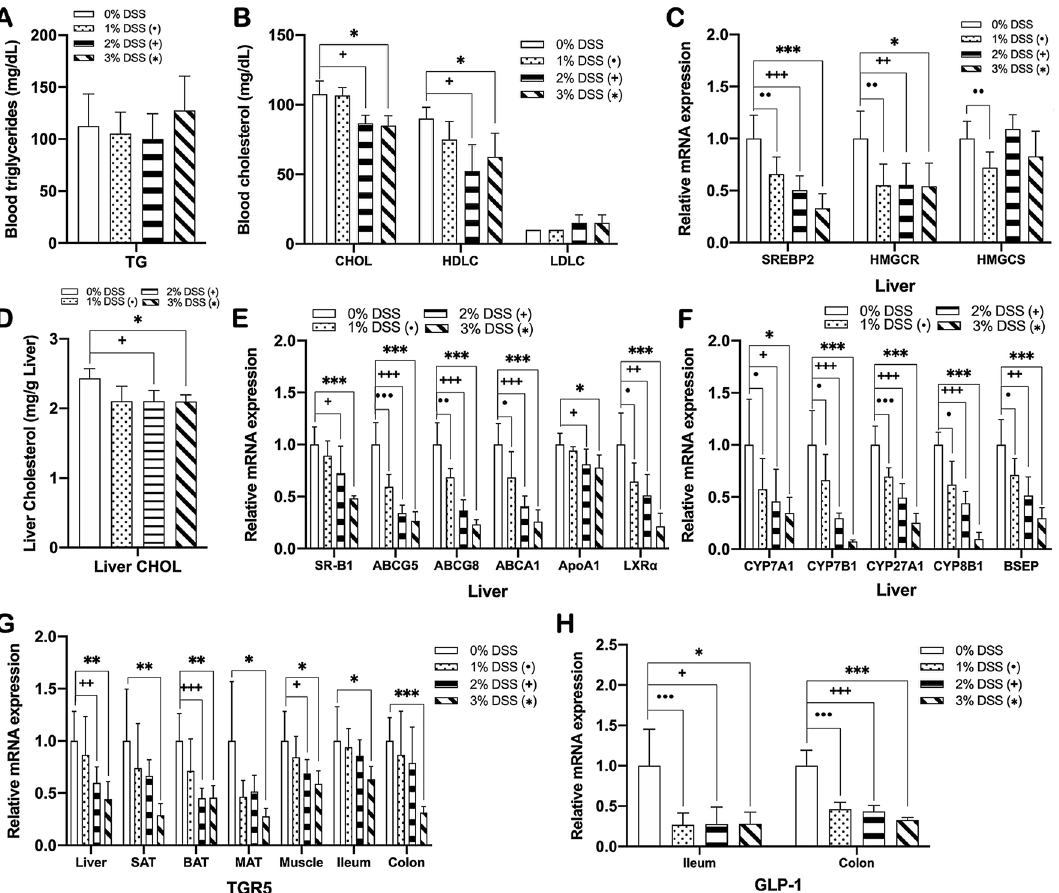
Figure 4. DSS-induced colitis impairs cholesterol and bile acid homeostasis. Blood levels of ( A ) TG, ( B ) total, HDL- and LDL-cholesterol, and ( D ) hepatic level of total cholesterol in DSS-induced colitis and non- colitis mice. mRNA expression of ( C ) cholesterol synthesis genes, ( E ) RCT genes, ( F ) bile acid synthesis genes in the liver, ( G ) bile acid receptor in the liver, SAT, BAT, MAT, skeletal muscle, the ileum, and the colon, and ( H ) GLP-1 in the ileum and the colon of DSS-induced colitis and non-colitis mice. Gene expression levels are normalized to GAPDH or Arbp expression. Data present mean ± SD for 5–8 mice in each group. Student’s two- tailed t-test was used for the analysis of differences between experimental groups. •,+, * p < 0.05, ••,++, ** p < 0.01, •••,+++, *** p < 0.001. CHOL, total cholesterol; HDLC, HDL-cholesterol; LDLC,